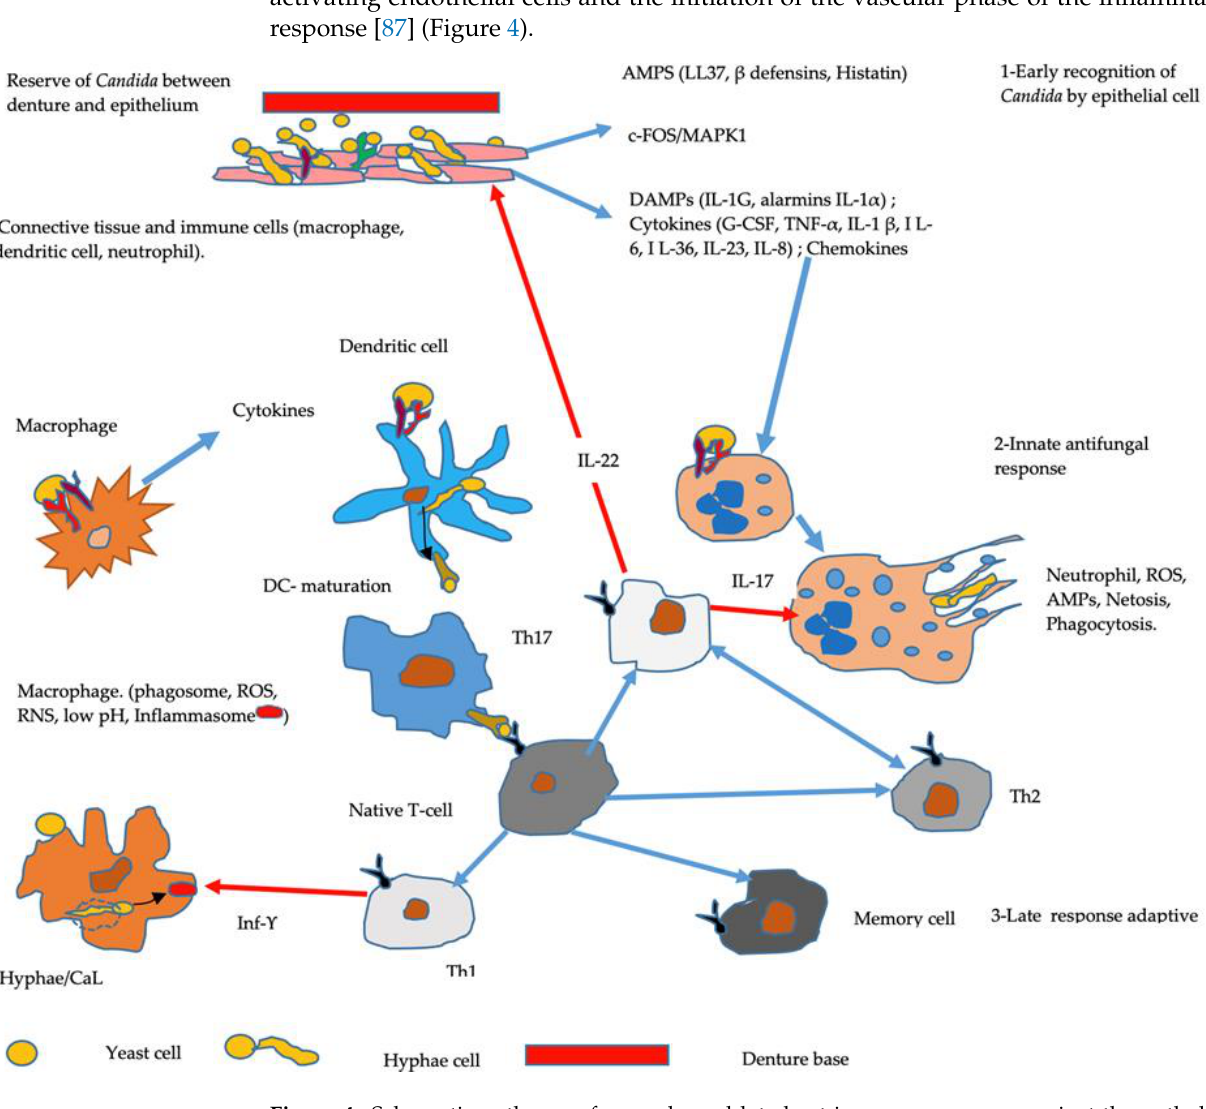
Figure 4. Schematic pathway of an early and late host immune response against the pathobiont C. albicans during mucosal invasion; early recognition of Candida (morphology of yeast and hyphal cells) by epithelial cells (neutrophils, macrophages, and dendritic cells) is efficient through pattern recognition receptors (PRRs), followed by innate and adaptive antifungal response